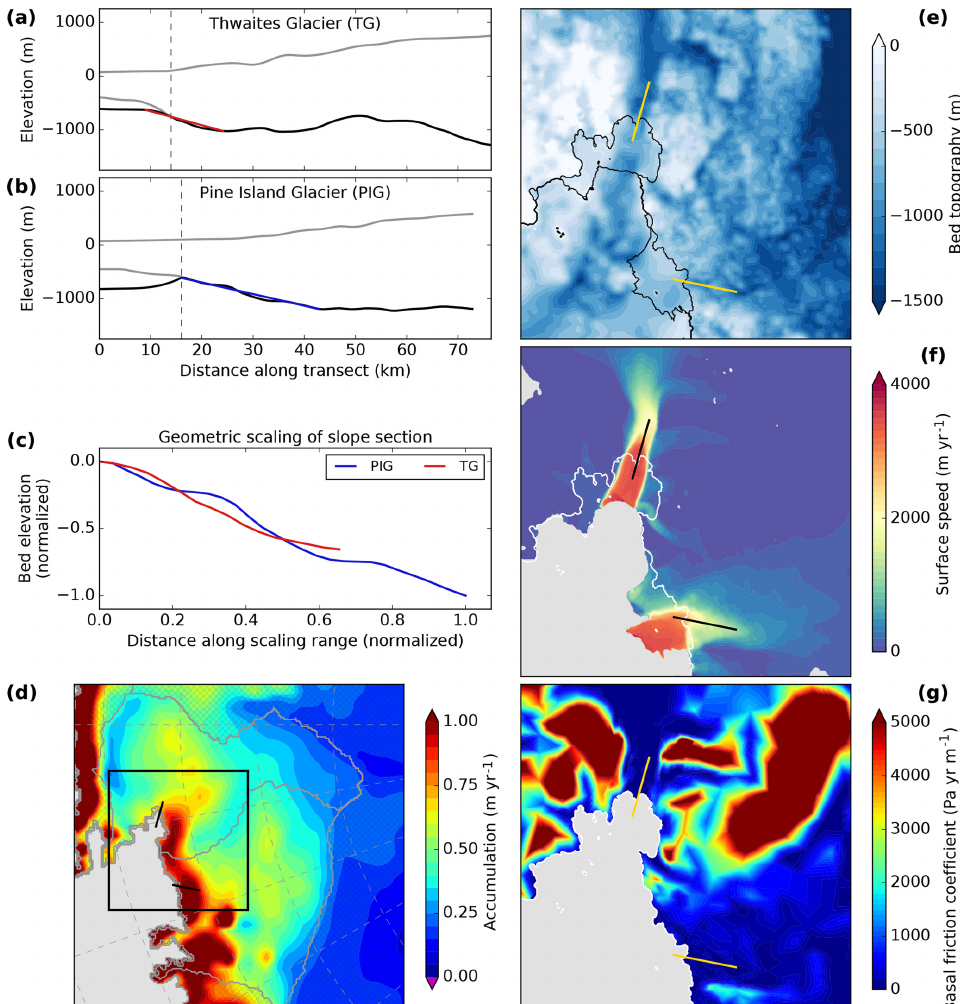
Figure 2. Scaling of bed geometry and maps of data involved in the response-time calculation (here shown exemplarily for Thwaites Glacier – TG – with respect to the reference Pine Island Glacier – PIG). (a) – (b) Elevation of ice surface (grey) and bedrock (black) with retrograde slope section (colored) that is used to infer the vertical scale and the slope magnitude for the transects shown in panels (d) – (g) . Panel (c) shows the bed geometry of the retrograde slope section, scaled with vertical and horizontal scaling factors (Table 1) and normalized to the dimensions of Pine Island Glacier. Maps of (d) surface mass balance (van Wessem et al., 2014), (e) bed topography (Fretwell et al., 2013), (f) surface velocity (Rignot et al., 2011) and (g) basal friction (Morlighem et al., 2013). Drainage basins are obtained from Zwally et al. (2012). The transects as shown in panels (a) and (b) are provided as black and yellow lines in panels (d) – (g) .